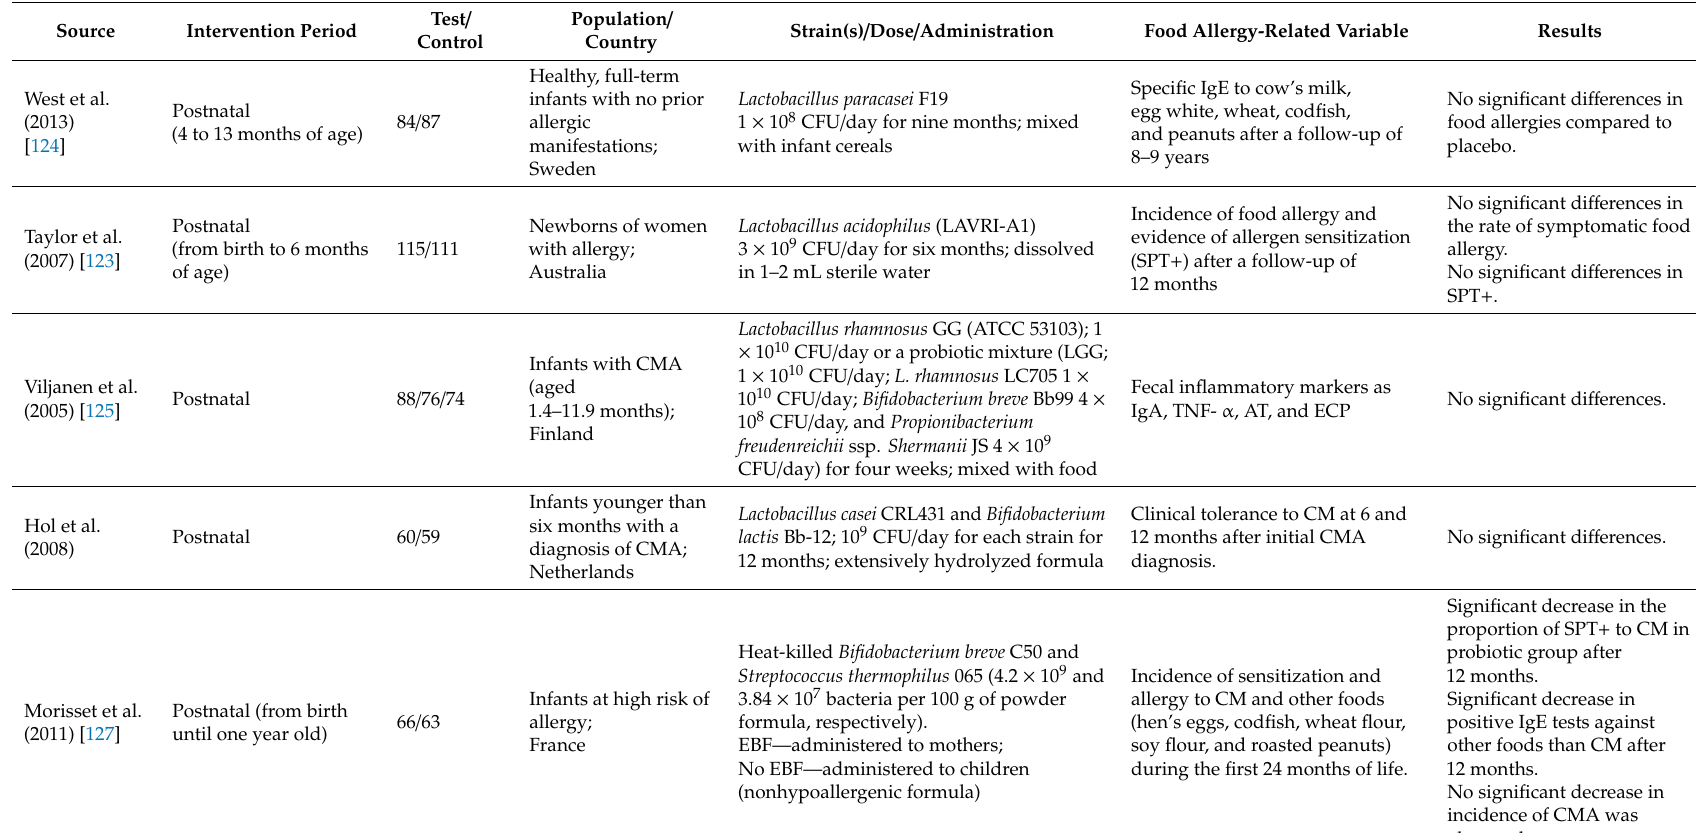
Table 3. Studies focused on the use of probiotics in postnatal period for the prevention of food